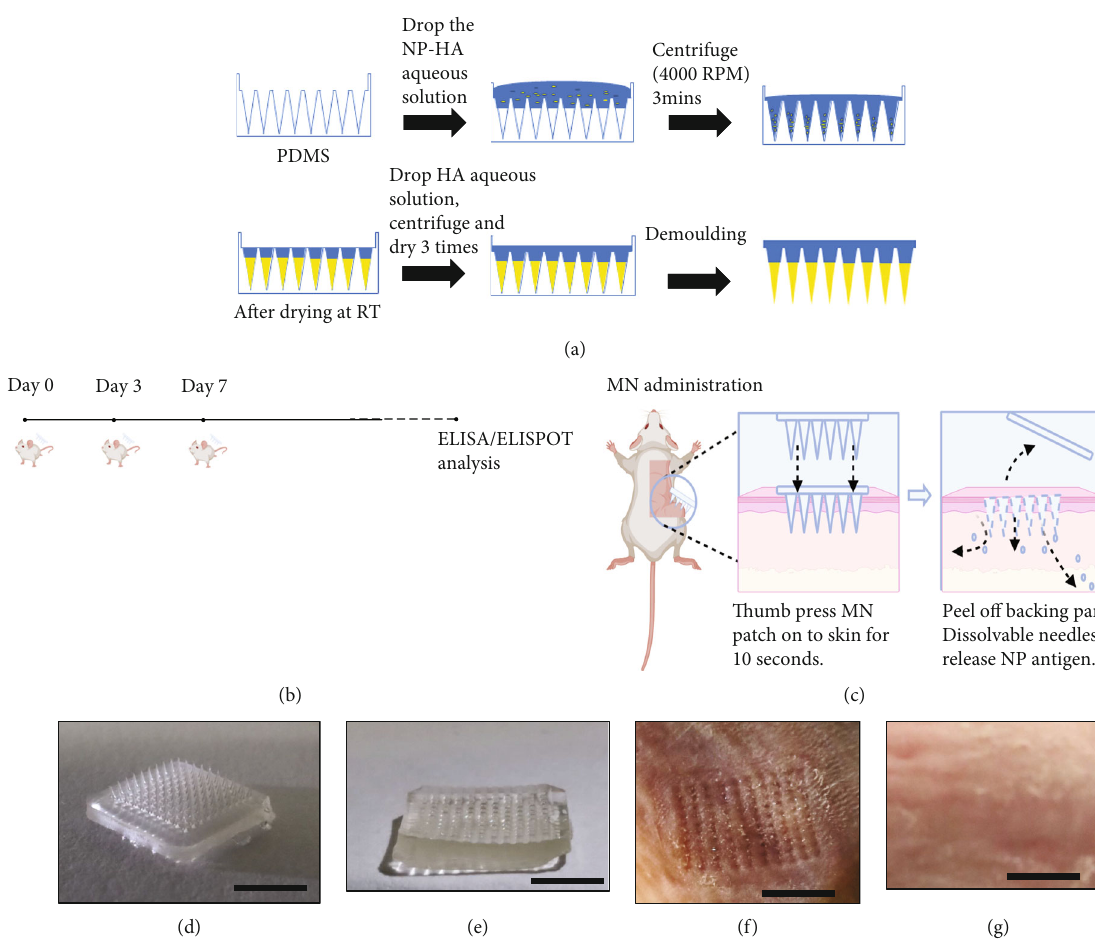
Figure 1: Schematic illustration of the vaccination with MN NPs: (a) MN NP fabrication process, (b) vaccination process, (c) MN NP administration on mice, image of MN NP patch (d) before deployment (tips present) (scale bar, 5 mm) and (e) after deployment (tips absent) (scale bar, 5 mm), and image of the mouse skin (f) immediately after injection (scale bar, 5 mm) and (g) 24 hours after injection (scale bar, 5